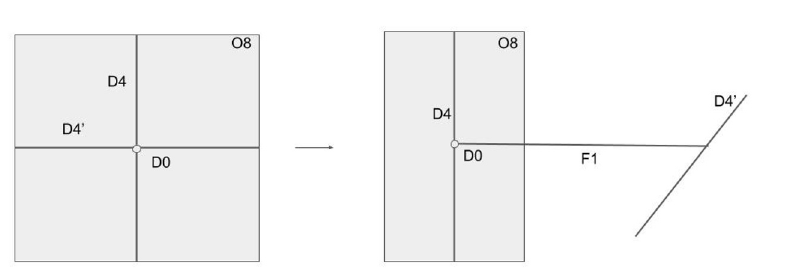
Figure 2 . Before expanding in x at ∞ , the index captures BPS operators associated with the left figure. After the expansion, the index counts BPS operators associated with the right